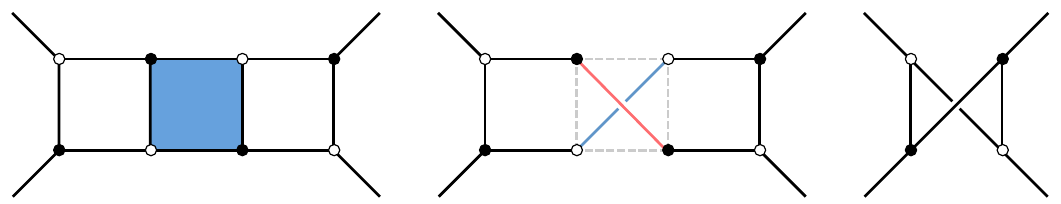
Figure 22. Instanton backreaction for a general BFT on a disk, which is left implicit in the (cid:12)gure.